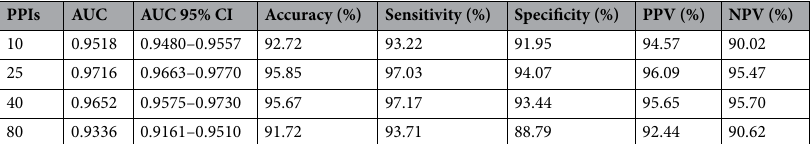
Table 5. Sensitivity, specificity, positive predictive value, negative predictive value, and accuracy in each patient between 10-beat, 25-beat, 40-beat, and 80-beat analytic programs.